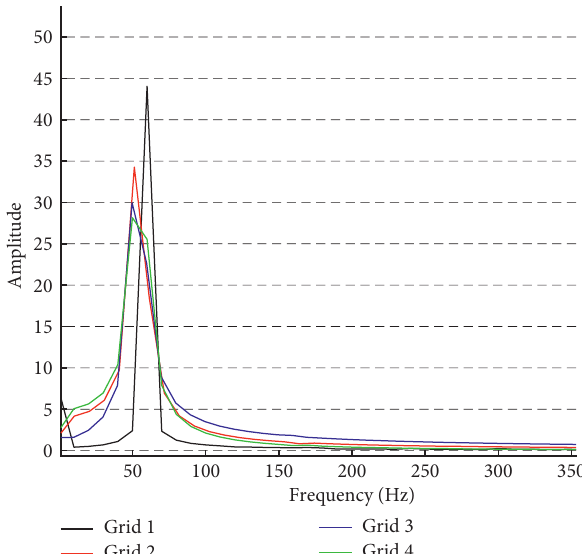
Figure 9: Lift frequency of different grids.